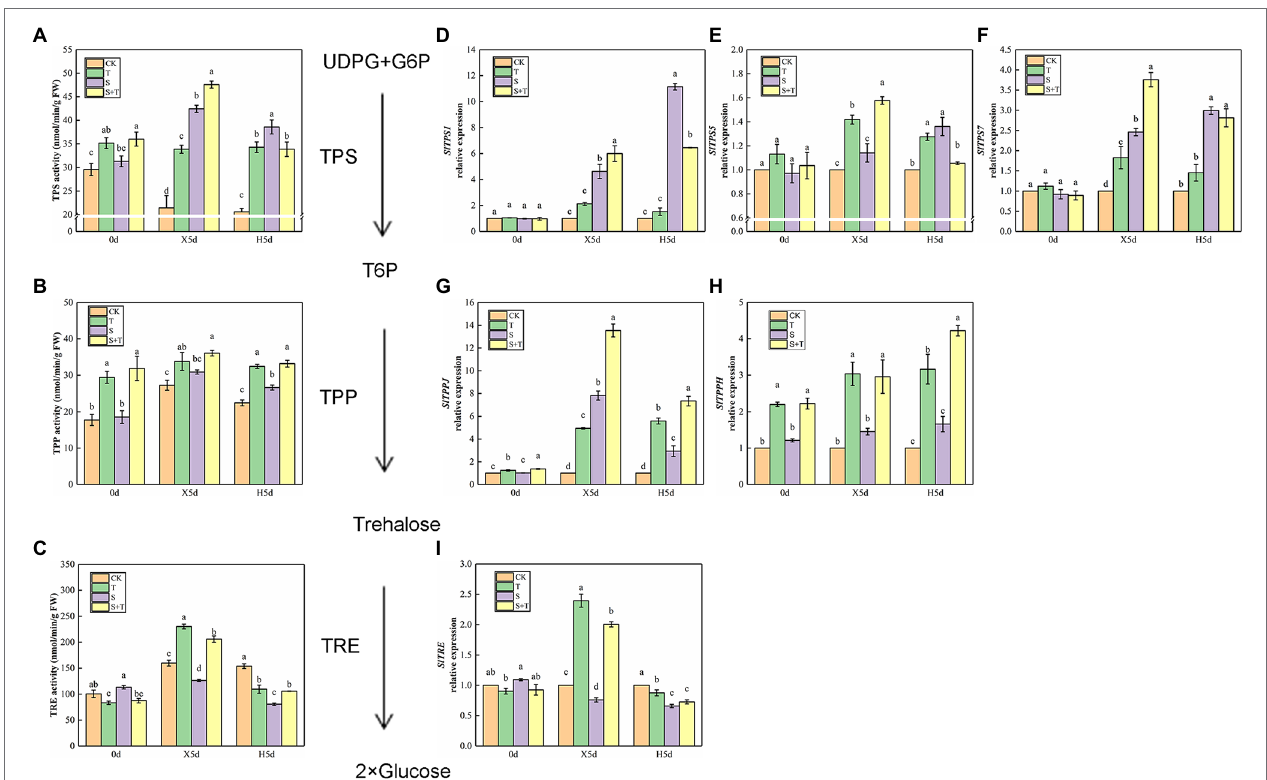
FIGURE 7 | Impact of exogenously applied trehalose on trehalose metabolism of tomato leaves under stress and non-stress conditions. The TPS–TPP pathway was the only trehalose synthesis pathway in higher plants. First, uridine glucose diphosphate (UDPG) and glucose 6-phosphate (G6P) were catalyzed by trehalose- 6-phosphate synthase (TPS) to form trehalose 6-phosphate (T6P). Second, T6P was catalyzed to trehalose by trehalose-6-phosphate phosphatase (TPP). Finally, trehalose was broken down by trehalase (TRE) into two molecules of glucose. (A)–(C) represent the activity of TPS, TPP, and TRE, respectively. (D)–(I) represent the expression levels of SlTPS1 , SlTPS5 , SlTPS7 , SlTPPJ , SlTPPH , and SlTRE , respectively. The results showed the mean ± SE of three replicates, and the different letters denote the significant difference among treatments ( p < 0.05), according to Duncan’s multiple test. CK, control; T, 10 mM trehalose; S, 150 mM NaCl; S + T, 150 mM NaCl +10 mM